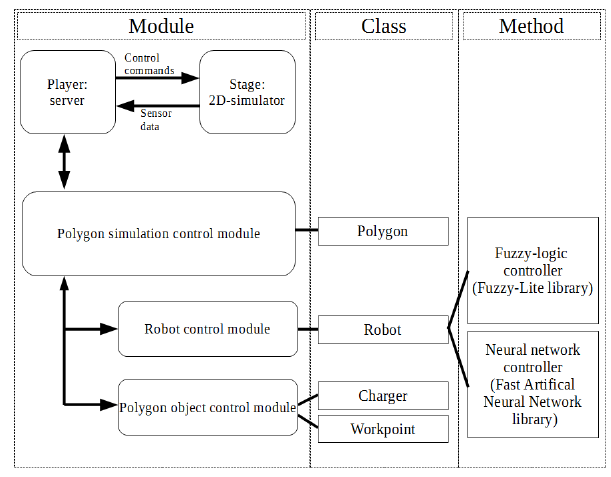
Figure 7: Simulation software structure.